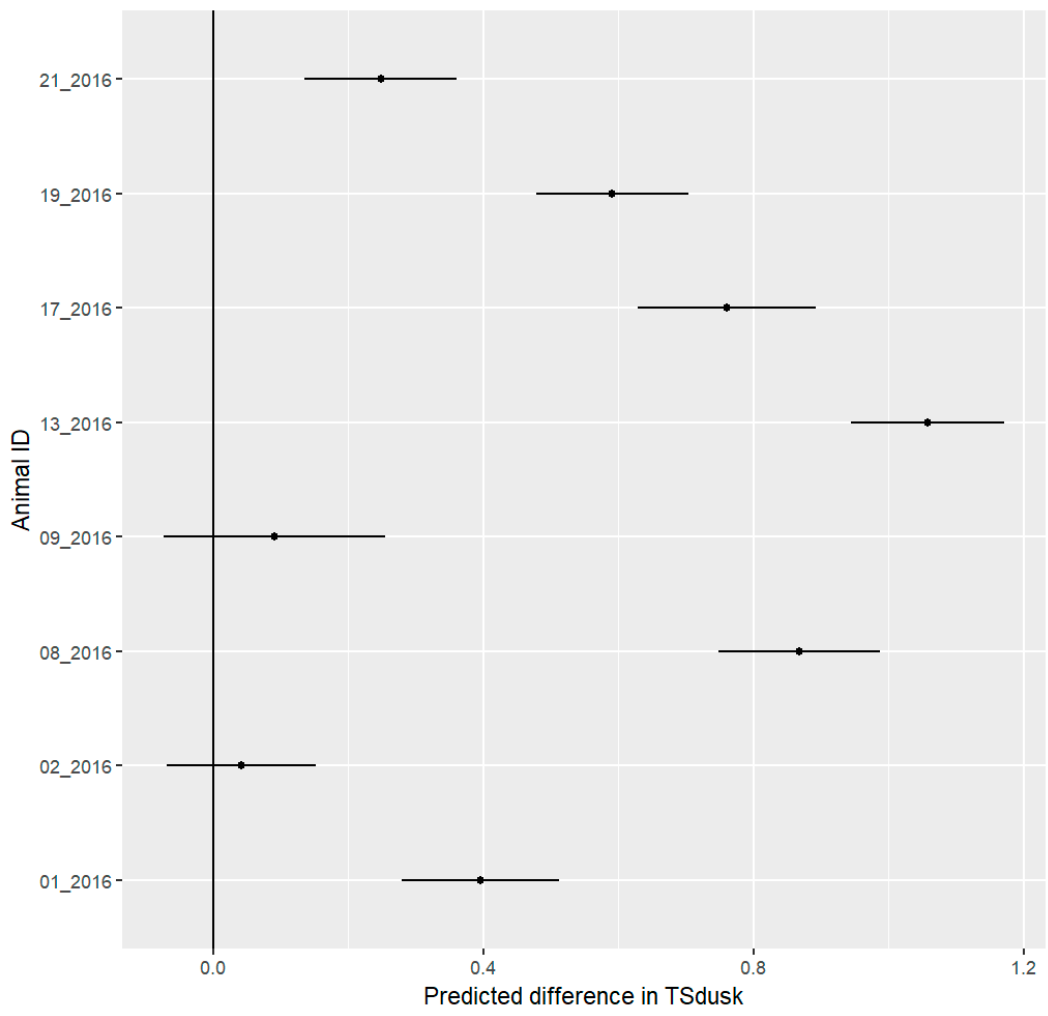
Figure 5. Mean predicted values with 95% confidence interval for differences in daily time span between activity onset and civil dusk (TSdusk) of eight hedgehogs between the pre-festival and festival phases. Negative values represent a shift in activity to a later time of the day during the festival, while positive values represent a shift in activity onset to an earlier time of the day during the festival. eight individuals show a significant positive